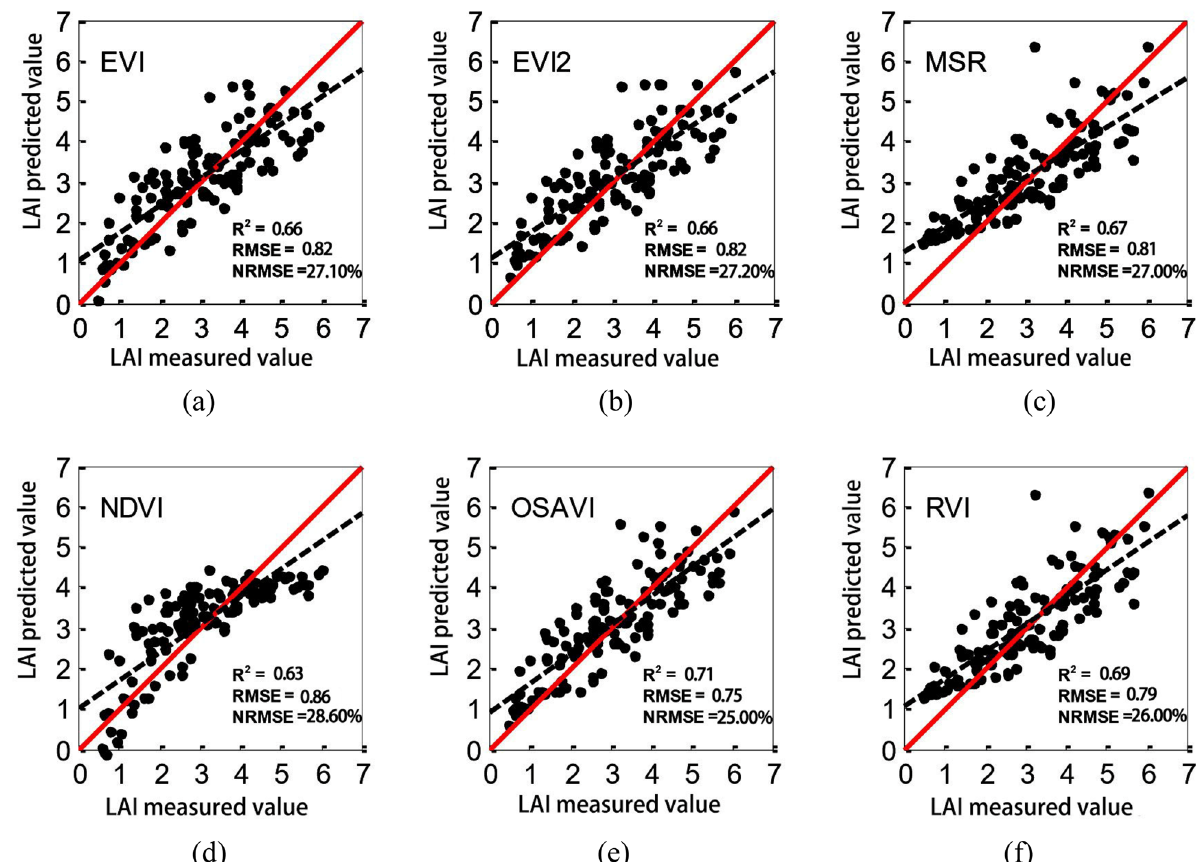
Figure 2. Scatter plots of predicted and measured LAI values for models with different vegetation indices.